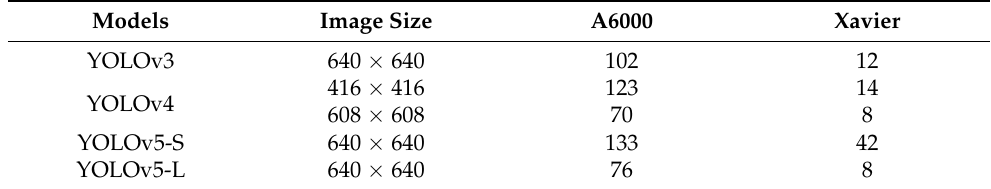
Table 7. The results of real-time performance (FPS) testing of each model. In this section, we use two GPU environments: one is Nvidia’s RTX A6000 equipped on the local server in laboratory; and the other GPU mounted on the Xavier in vehicle is Nvidia’s 512-Core Volta GPU with Tensor Cores. Models Image